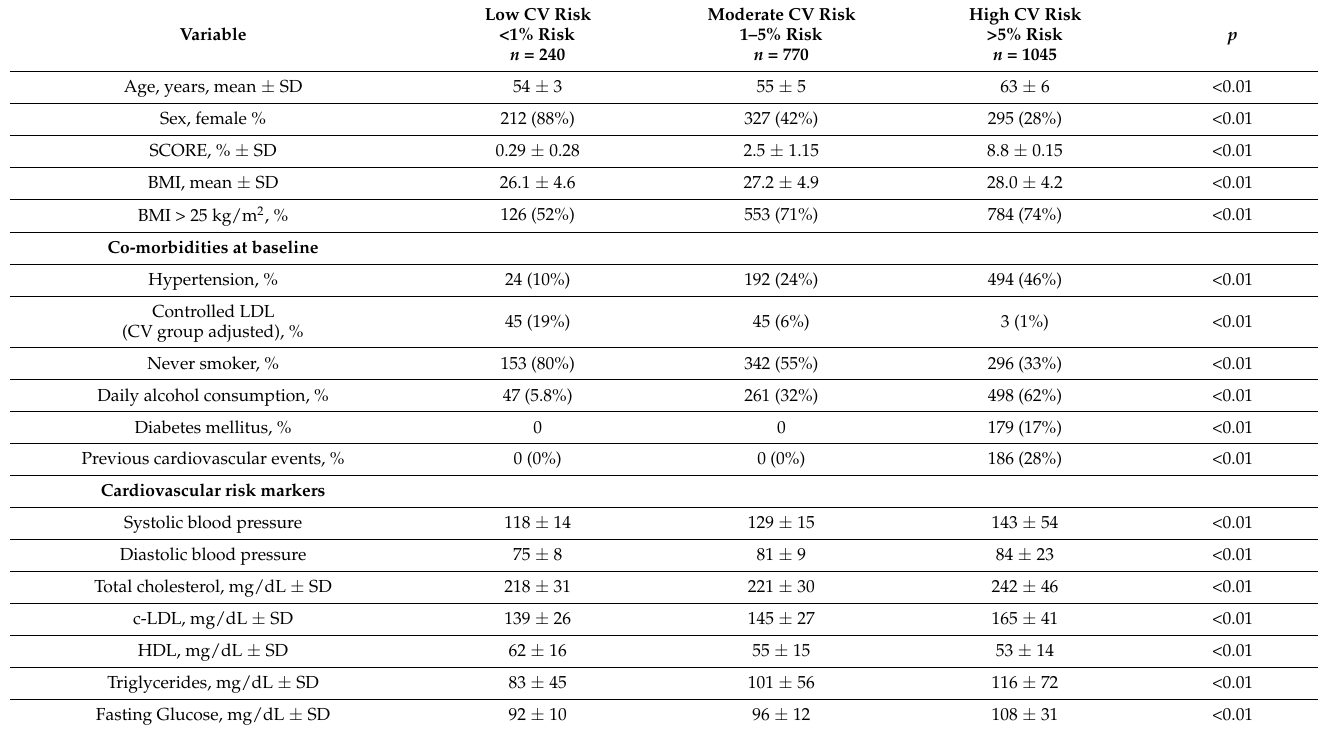
Table 1. Population